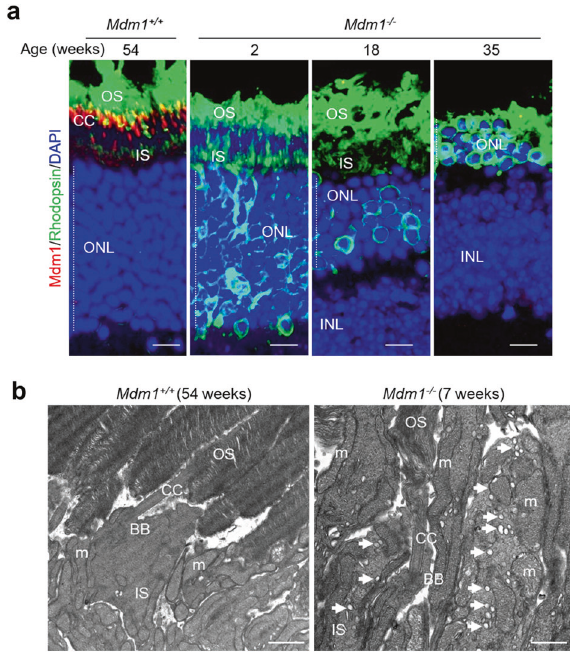
Fig. 5 Distribution of rhodopsin and vesicles in the photoreceptor cells of the retinas of Mdm1 + / + and Mdm1 − / − mice. a Immuno fl uorescence staining of Mdm1 (red) and rhodopsin (green) in the photoreceptor cells of Mdm1 + / + and Mdm1 − / − mice at the indicated ages. Representative images are shown ( n > 5 per group). Scale bar, 10 μ m. b TEM images of the photoreceptor cells of the retina in Mdm1 + / + and Mdm1 − / − mice. Arrows indicate vesicles in the IS. Scale bar, 1 μ m. RPE, retinal pigmented epithelial cells; OS, outer segment; CC, connecting cilium; BB, basal body; IS, inner segment; ONL, outer nuclear layer; INL, inner nuclear layer; m,